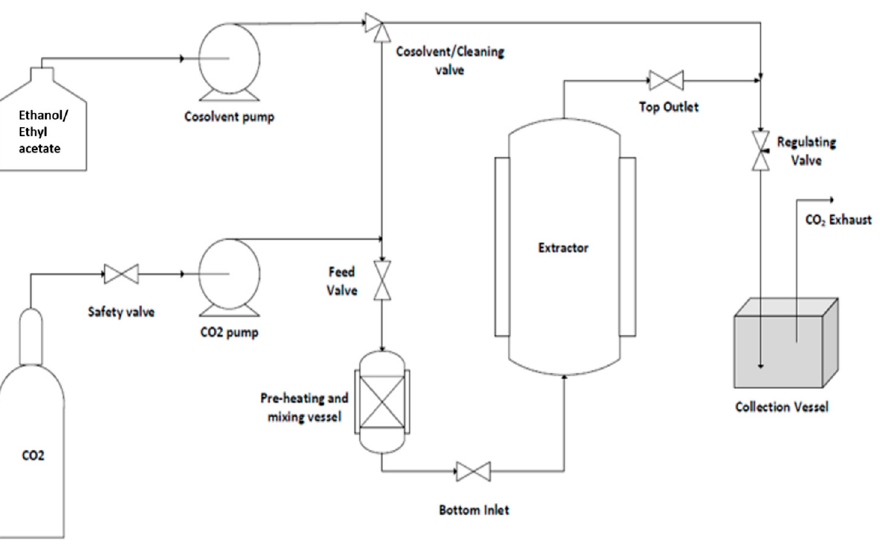
Figure 2. Simplified scheme of the SFE installation. Reprinted with permission from [25]. Copyright 2021, Elsevier.